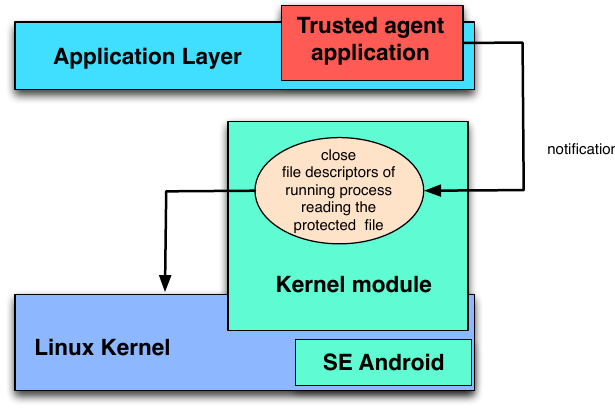
Figure 14. Kernel module used to close existing handles to protected